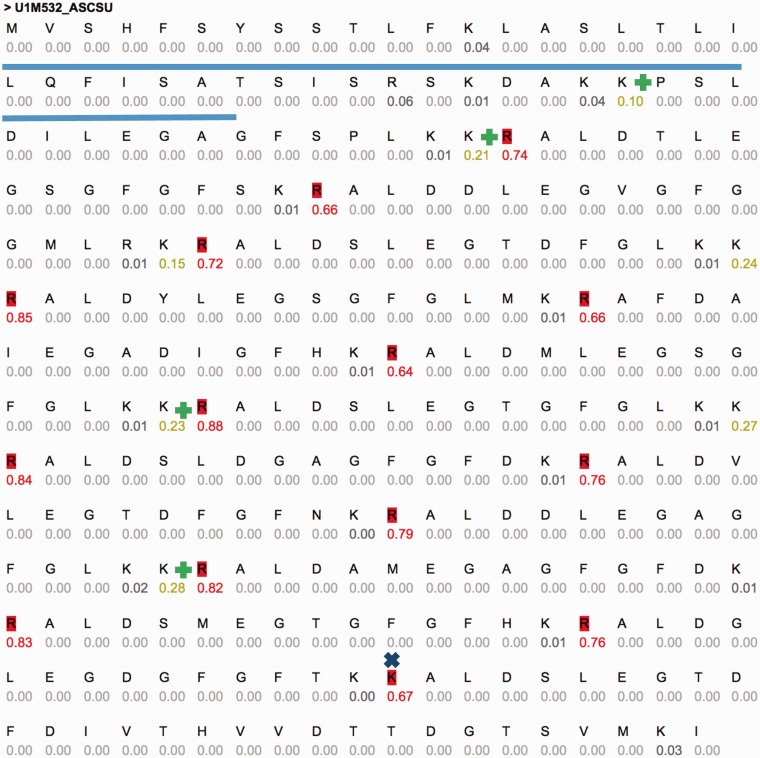
Example predictions using CleavePred’s website interface. Graphical view of CleavePred results for Ascaris suum genome (Pig roundworm, U1M532_ASCSU, 279 AA). While along the sequence there are 40 K/R residues, only 14 of them are predicted as cleavage sites (colored red, probability >0.5). Each residue is associated with its cleavage prediction. The repeated nature of the sequence is evident. The Signal sequence is underlined. X marks a missed cleavage site by ProP and additional cleavage sites according to NeuroPed (marked +).